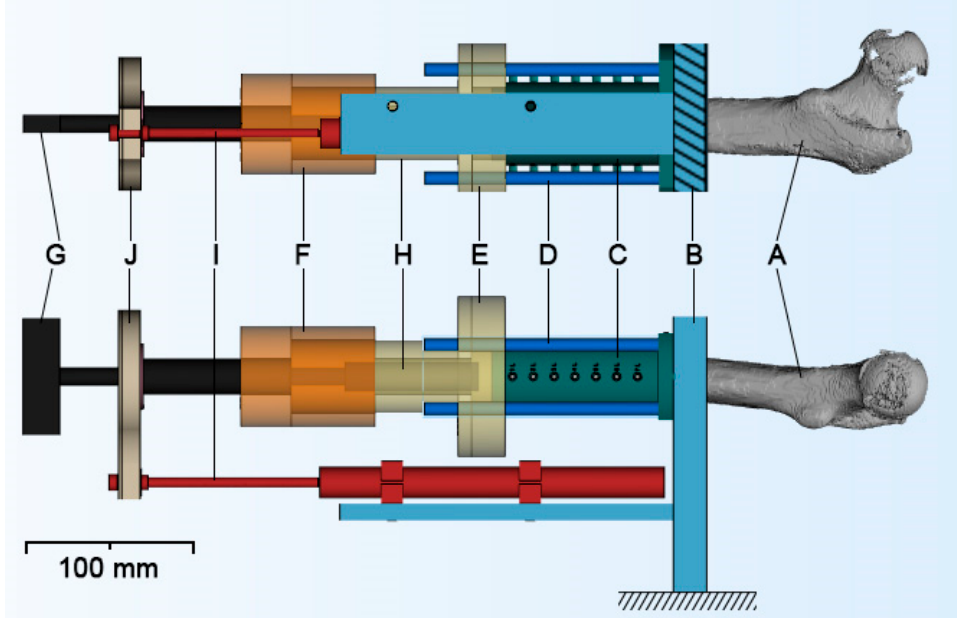
Figure 2. The femoral specimen (A) is mounted into the mounting platform (B) with the aid of drill guides (C) and four steel 8 mm rods (D). The drill guides accommodate one K-wire and six thermocouples each. Two flanges, one (E) attached to the drill guide and the steel rods and the other one (F) attached to the T-handle Hudson (G), allow exact alignment of the drills, the thread tap, and finally the implant (H). A displacement transducer (I) records the penetration depth of the instrument and the implant. It is firmly attached to the mounting platform, and its stroke is connected with the T ‐ handle through a bearing (J).